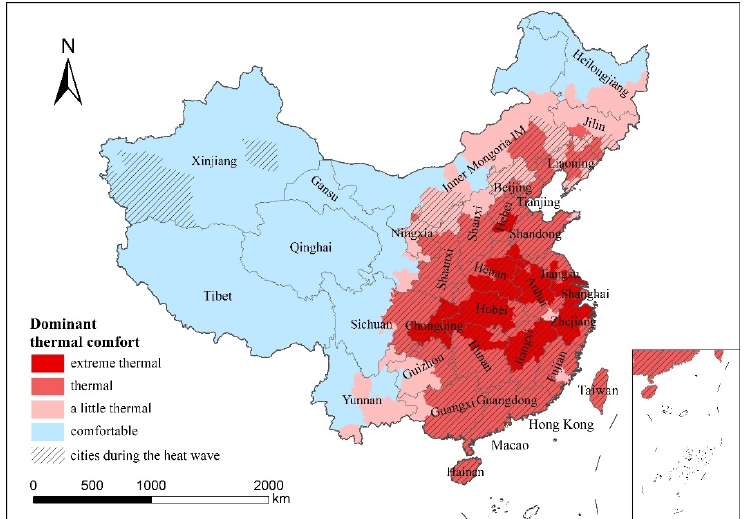
Figure 8. Distribution of dominant thermal comfort levels in different cities during the heat wave (shaded areas are cities during the heat wave).